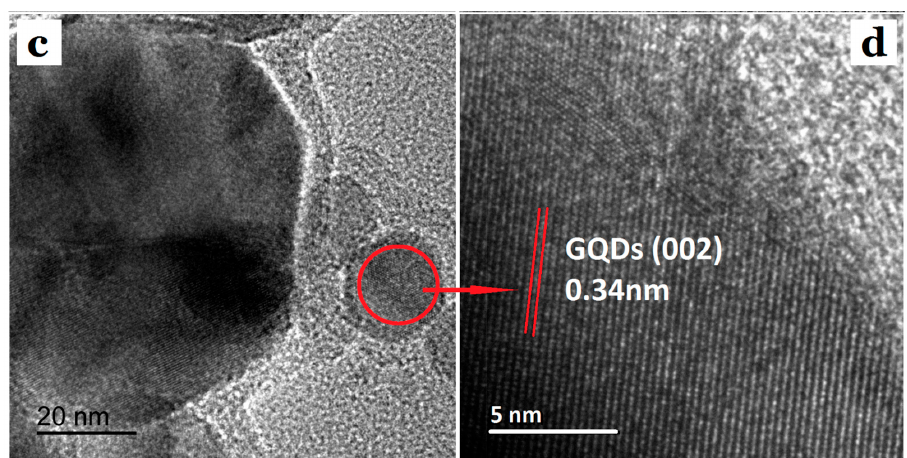
Figure 2. Morphology and microstructure images of GQDs@ZIF-8 composites. ( a ) TEM image of GQDs@ZIF-8, ( b ) TEM image of GQDs with diameter distribution graph, ( c ) HRTEM image of GQDs@ZIF-8, ( d ) HRTEM image of a signal GQD.